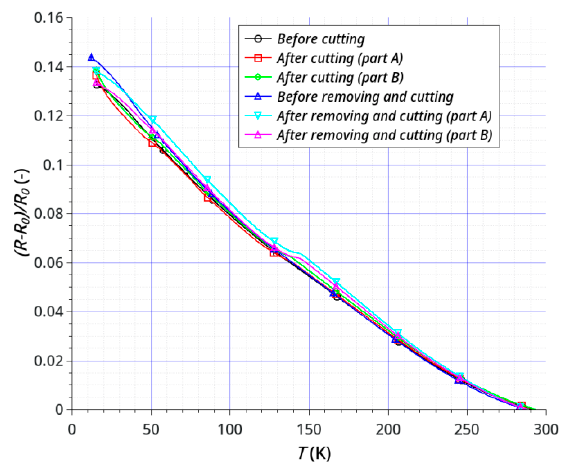
Figure 10. Relative changes in the sample resistances before and after the laser treatment ( R 0 —initial resistance of the sample at T init = 293 K).